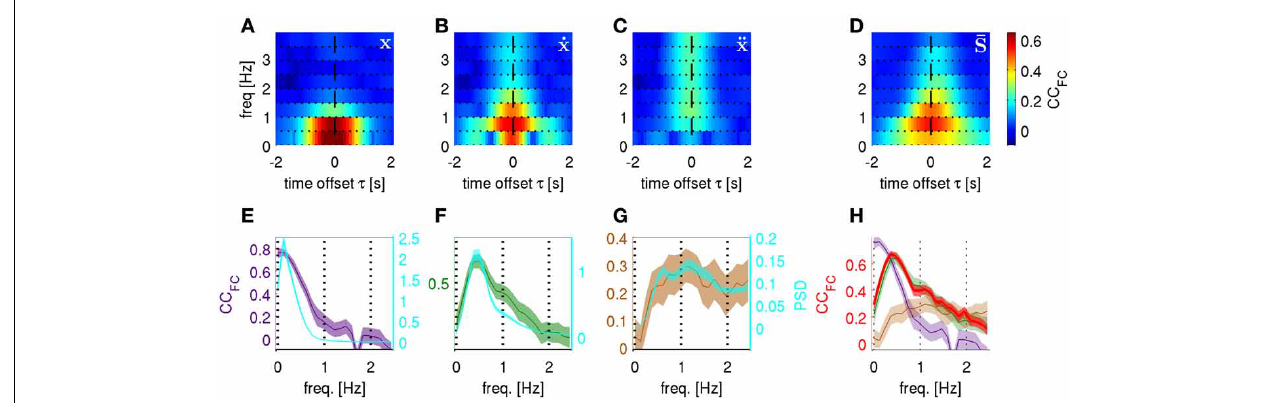
FIGURE 9 | Time-frequency resolved decoding from “kinematic copy + white noise” models and from real ECoG. Correlation coefficients between predicted and actual frequency components (CC FC ) computed at different carrier frequencies f and time offsets τ . The kinematic copy (std = 1) was summed up with white noise (std = 20). (A) “position + noise” model predicting position, (B) “velocity + noise” predicting velocity and (C) “acceleration + noise” model predicting acceleration. (D) The CC FC for real ECoG data predicting trajectory derivatives, i.e., position, velocity, and acceleration (averaged over all subjects and also all trajectory derivatives, see section Frequency Resolved Decoding of Position, Velocity, and Acceleration).